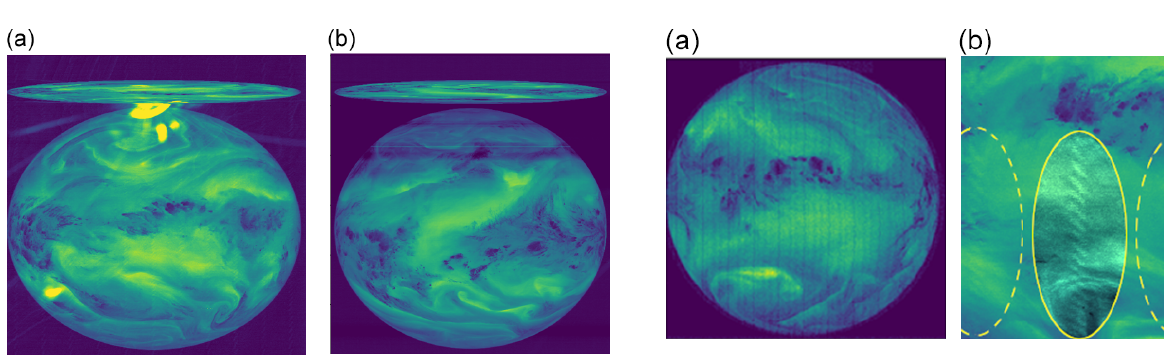
Figure 5. Two examples of the “suspicious pattern” anomaly: in (a) the vertical stripes are visible (file: METEOSAT2-MVIRI- MTP10-NA-NA-19810817223000, channel: WV). In (b) the ovals indicate the position of the suspicious pattern; the middle oval has been altered to enhance the visibility of the pattern (file: METEOSAT4-MVIRI-MTP10-NA-NA-19901015013000, channel: WV). The pixel values are the raw digital counts (see also Fig. 2;